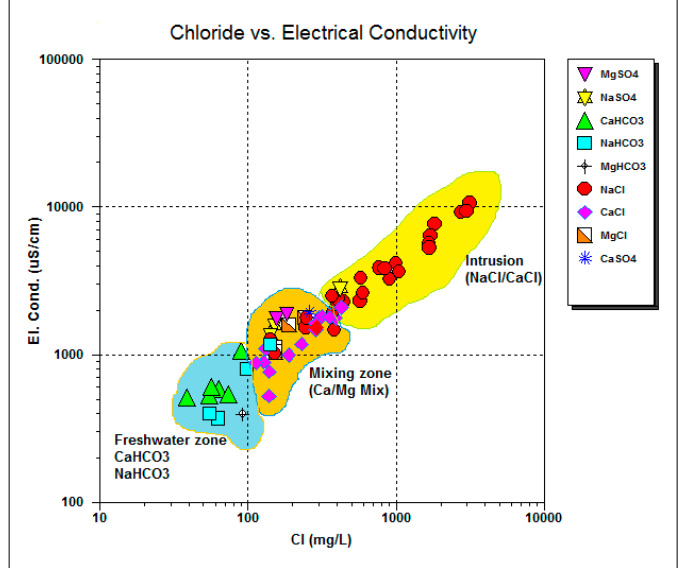
Figure 5. A plot of chloride vs. electrical conductivity showing fresh groundwater conditions, saltwater intrusion, and mixing between the two end members.